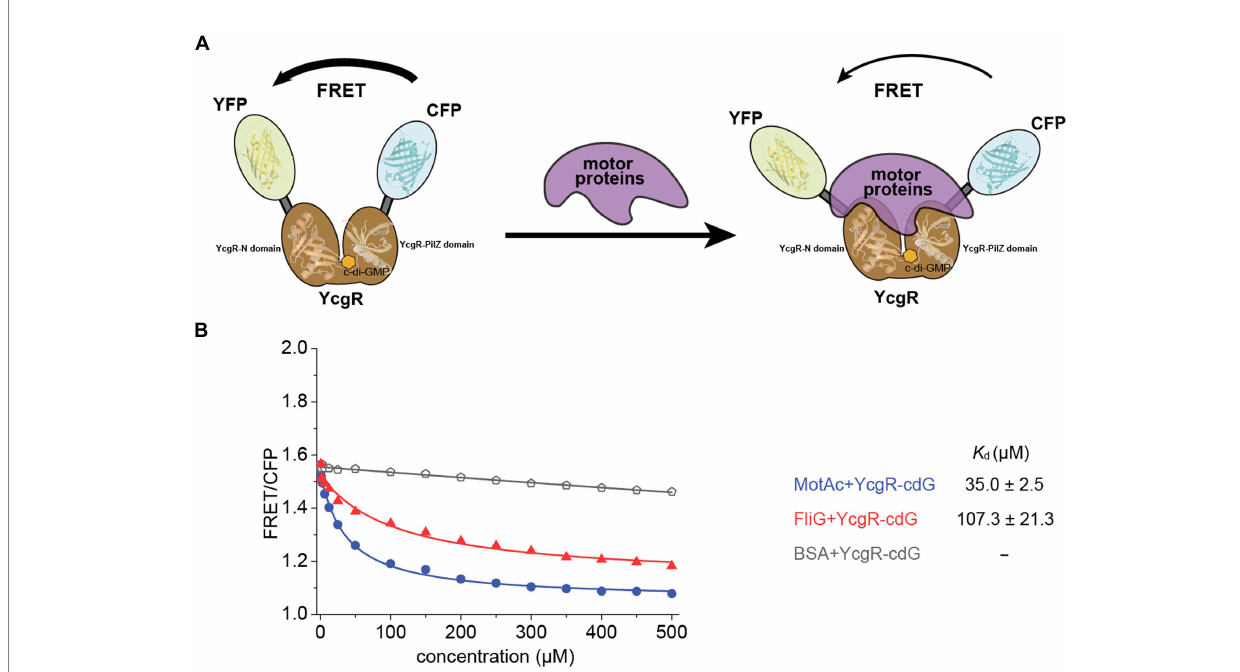
FIGURE 2 The binding of c-di-GMP increased the motor proteins’ affinities of YcgR. (A) Scheme illustrating the detectable change in FRET caused by binding of YcgR oversaturated with c-di-GMP (cdG) to motor proteins. The YcgR-c-di-GMP complex, in the absence of motor proteins, possessed close fluorescent subunits, and FRET is maximal. Motor protein binding induced a conformational change separating the fluorescent domains, decreasing FRET efficiency. The overlap of motor proteins and c-di-GMP in the diagram did not mean motor proteins bound to c-di-GMP. Instead, the MotA binding site was involved in one c-di-GMP binding motif. (B) Profile of the FRET/CFP emission fluorescence ratio along the increasing concentration of motor proteins (blue line for MotAc and red line for FliG). The K d ( μ M) between YcgR and motor proteins were calculated accordingly and shown as mean ± SE. The experiments were repeated three times, and representative examples were